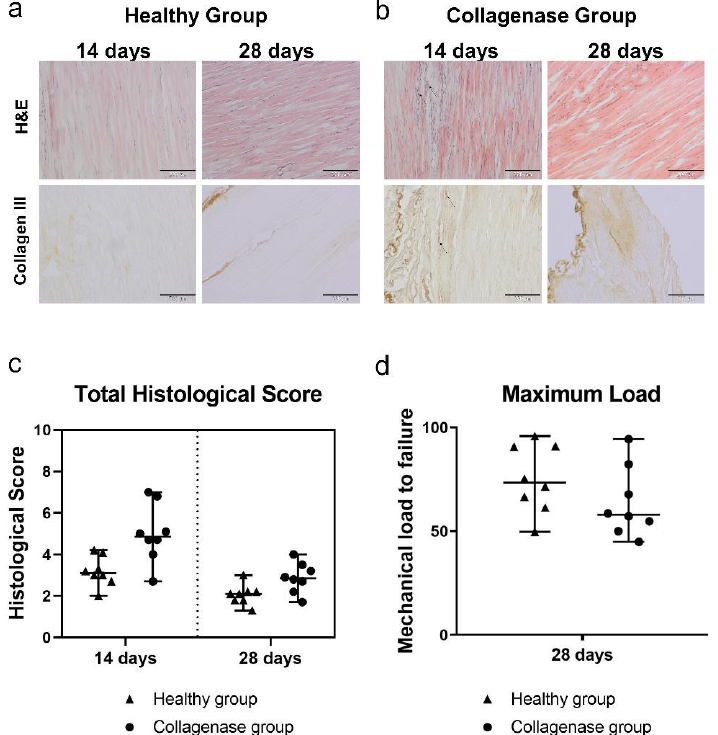
Figure 2. Histological and biomechanical analysis for the untreated control groups. Hematoxylin & Eosin (H&E) staining and Collagen III immunohistochemical (IHC) staining of the ( a ) healthy group (untreated / untreated) and ( b ) collagenase group (collagenase / untreated) at both 14 and 28 days post-treatment. Scale bar indicates 200 μm. ( c ) Total histological score for tendons in the healthy and collagenase group at 14 and 28 days post-treatment. Median with range reported. ( d ) Maximum load for tendons in the healthy and collagenase group at 28 days post-treatment. Median with range reported.